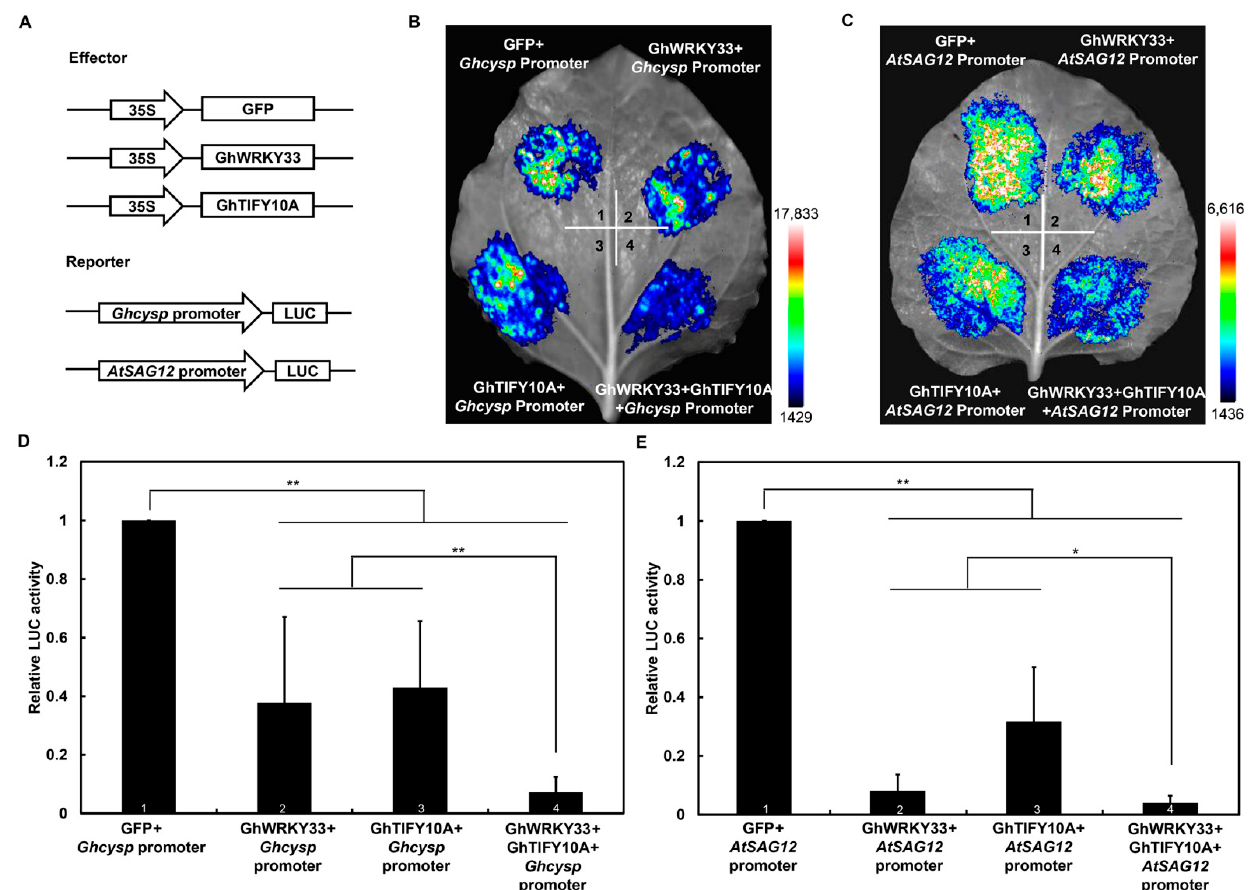
Figure 7. GhWRKY33 and GhTIFY10A synergistically suppress the expression of SAG s in the dual- luciferase reporter assay. ( A ) Sketch of the effector and reporter constructs. The GhWRKY33 and GhTIFY10A were cloned into the effector vector pGreenII 62-SK , and the promoters of Ghcysp and AtSAG12 were cloned into the reporter vector pGreenII 0800-LUC . ( B – E ) GhWRKY33 and GhTIFY10A synergistically suppress Ghcysp and AtSAG12 expression in transient dual-luciferase reporter systems. The relative LUC activity of the combination of pGreenII-62-SK empty vector and Ghcysp and AtSAG12 promoter were set as 1. Data from six biological replicates were analyzed by ANOVA, and asterisks indicate significant differences (* p < 0.05; ** p <